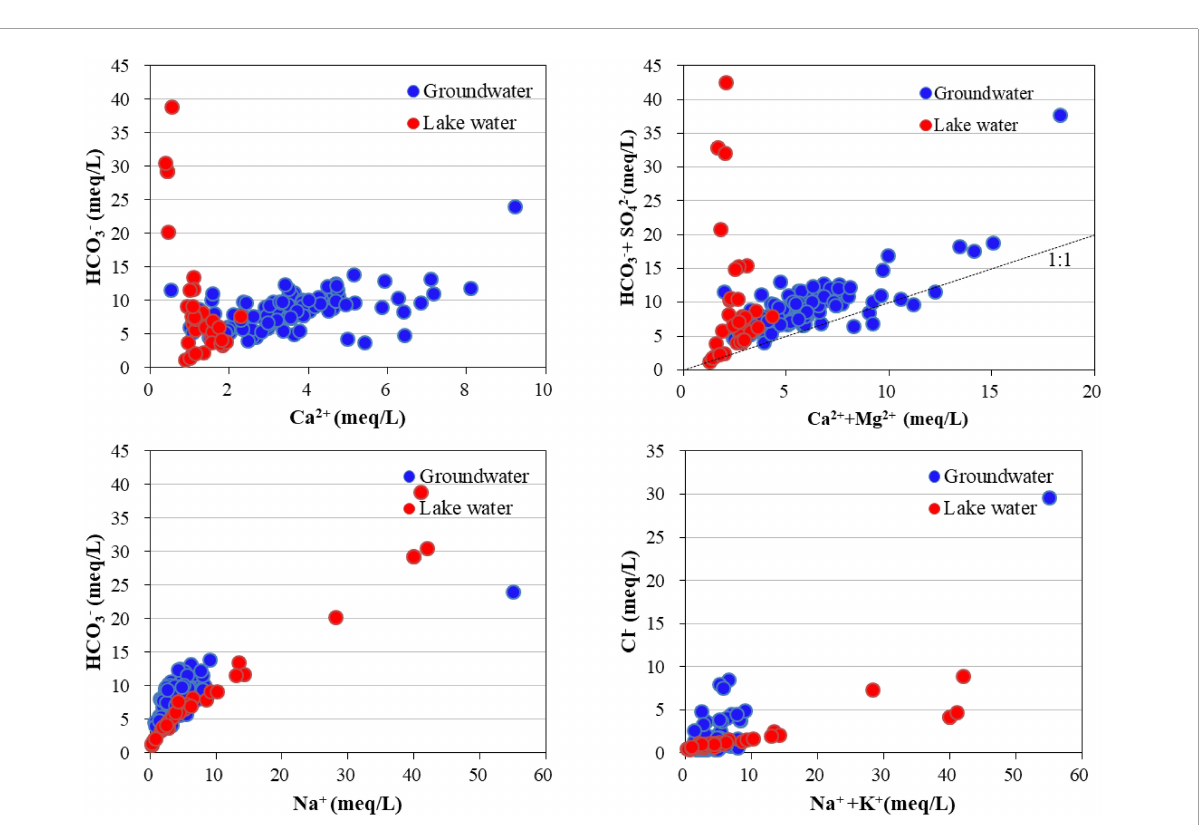
Chen et al., 2020). The positive correlation between TDS and δ 18 O in the MNNR lake water ( R 2 = 0.4031) was not evident in the groundwater ( Figure 7A ). As the degree of evaporation increased, the δ 18 O in the lake water reached 2.26